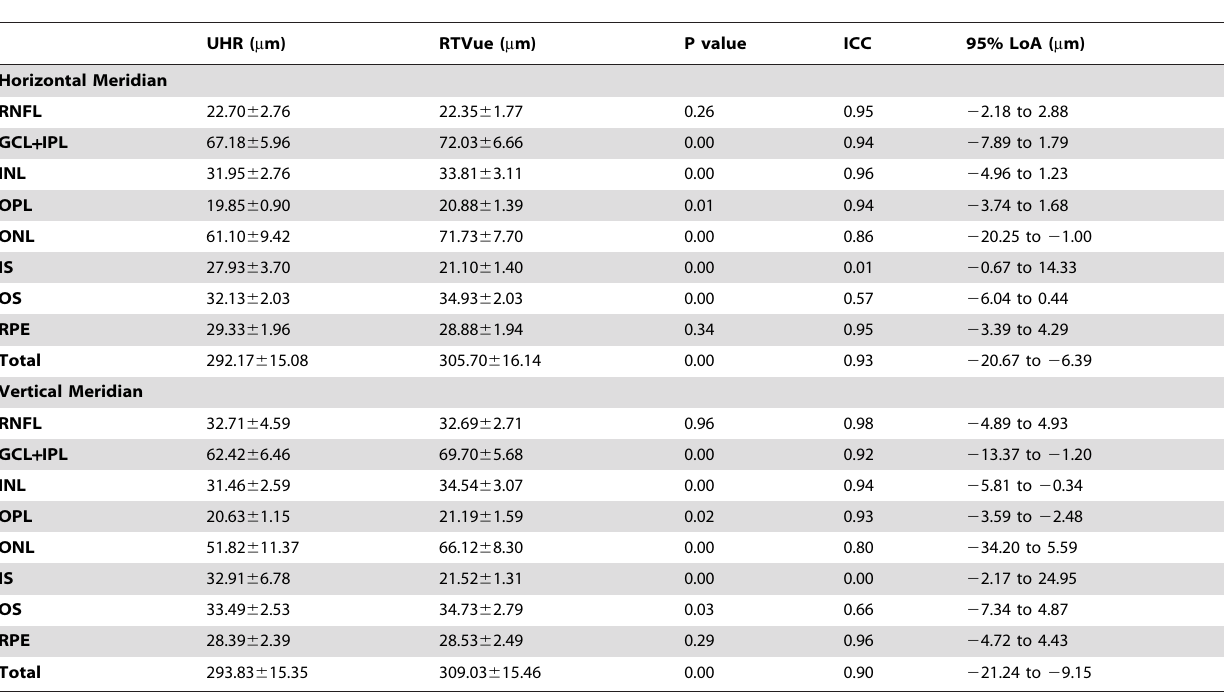
Table 4. Comparison of the thickness measurements for eight intra-retinal layers and total retina between UHR-OCT and RTVue100